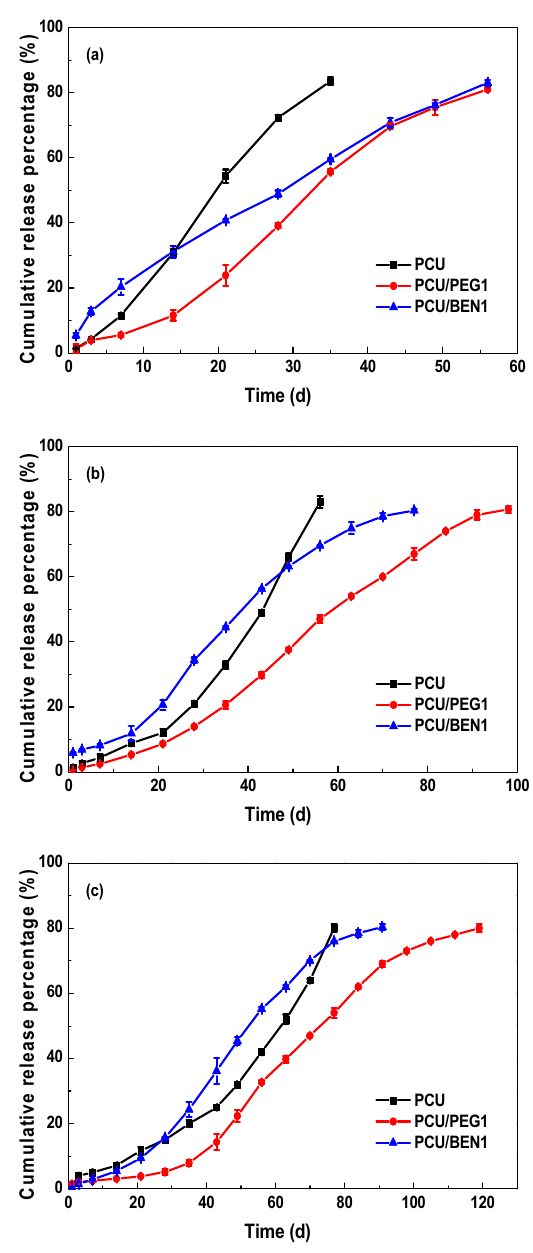
Figure 9. Nitrogen release behaviors of coated urea with different POSS contents at three coating rates ( a ) 2 wt%, ( b ) 2.5 wt% and ( c ) 3 wt%. PU/1 wt% POSS-PEG nanocomposite (PCU/PEG1), PU/1 wt% POSS-BEN nanocomposite (PCU/BEN1) and pure polyurethane